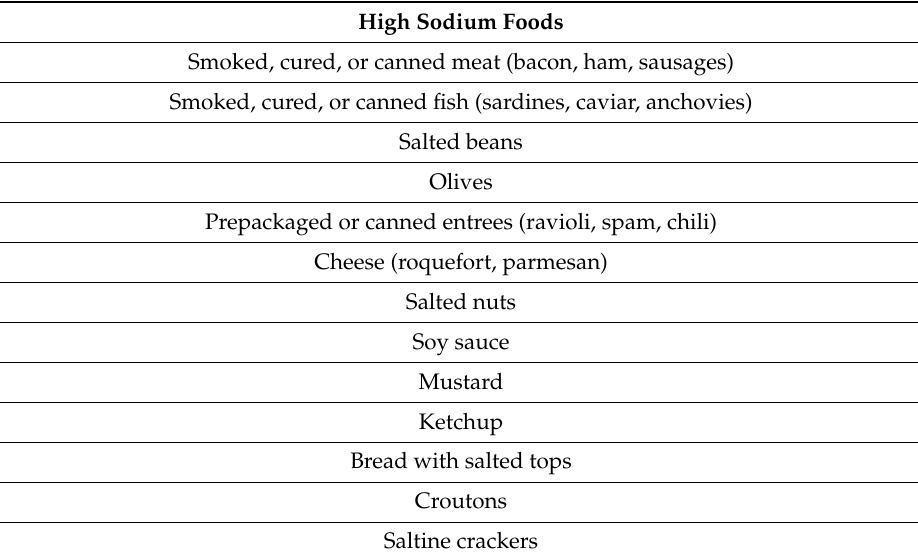
Table 5. Foods with the highest content of